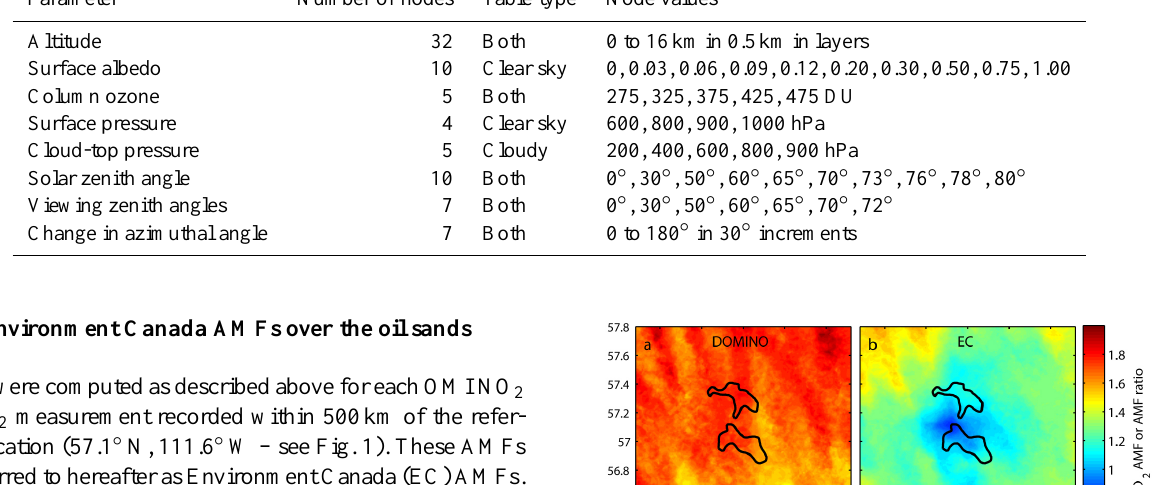
Table 2. Air mass factor look-up table nodes. Parameter Number of nodes Table type Node values